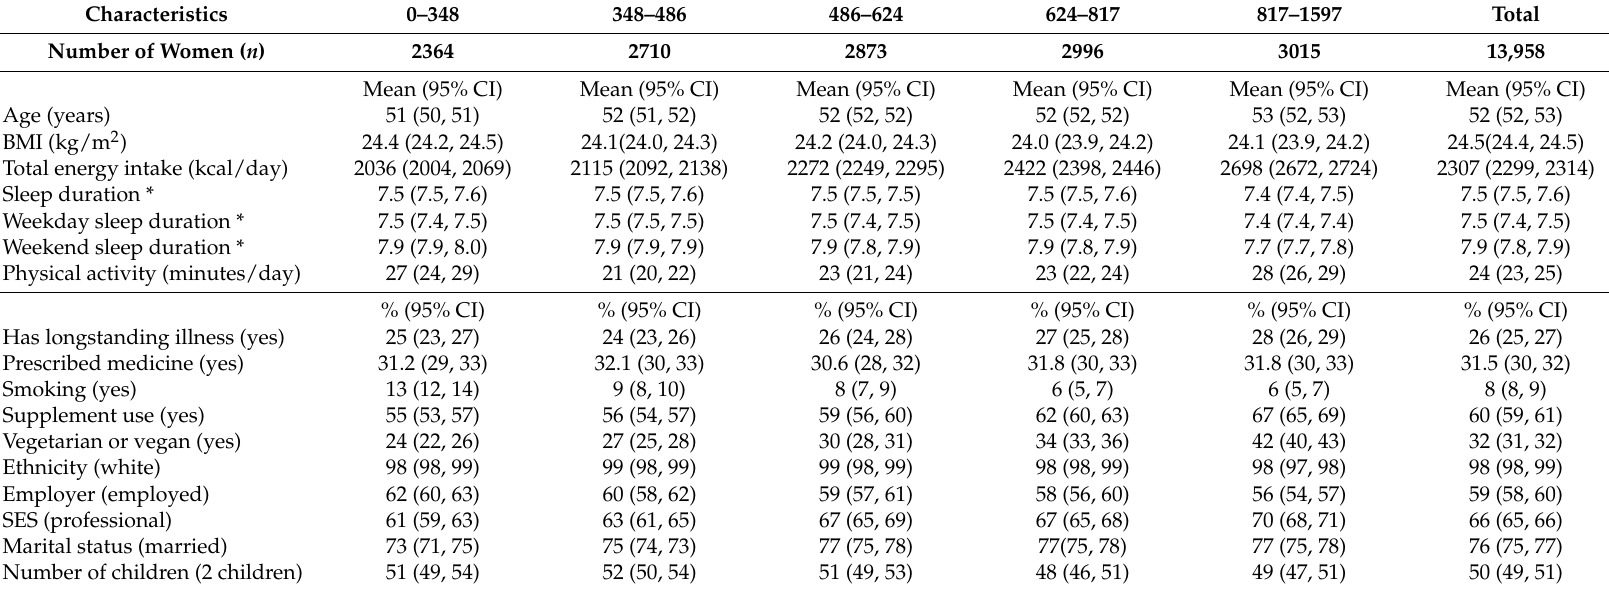
Table 1. Baseline characteristics by quintile of total FV intakes from the